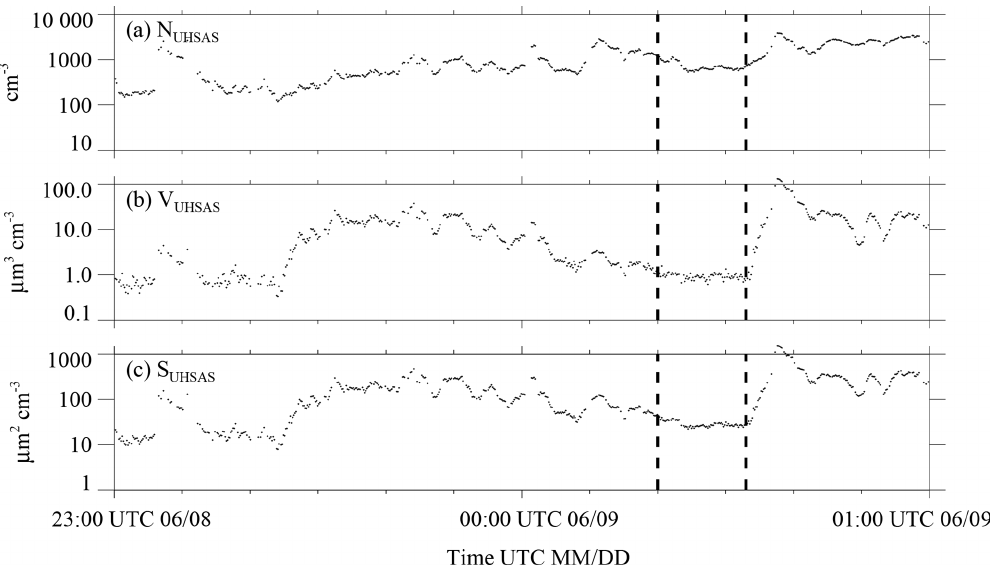
Figure 6. Aerosol properties centered on 1 of the 20 onshore trajectories that arrived at the Arauco site between 29 May to 28 June. This trajectory arrival occurred at 00:00UTC on 9 June. (a) UHSAS concentration; (b) UHSAS aerosol volume; (c) UHSAS aerosol surface area. Aerosol properties shown here were filtered using the procedure described in Appendix B. Vertical dashed lines mark the subset of the 2h segment we picked (subjectively) as being representative of onshore-moving air that was relatively unaffected by continental aerosols compared to adjacent portions of the 2h